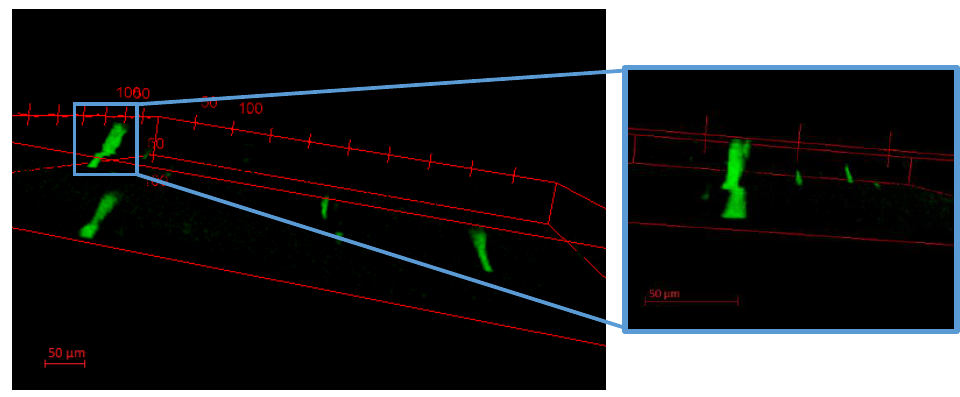
Figure 11. Tomography images made using a 2p-fluorescence microscope of skin sample (1 mm × 1 mm × 50 µm) after 24 h of exposure to Ir@SiO 2